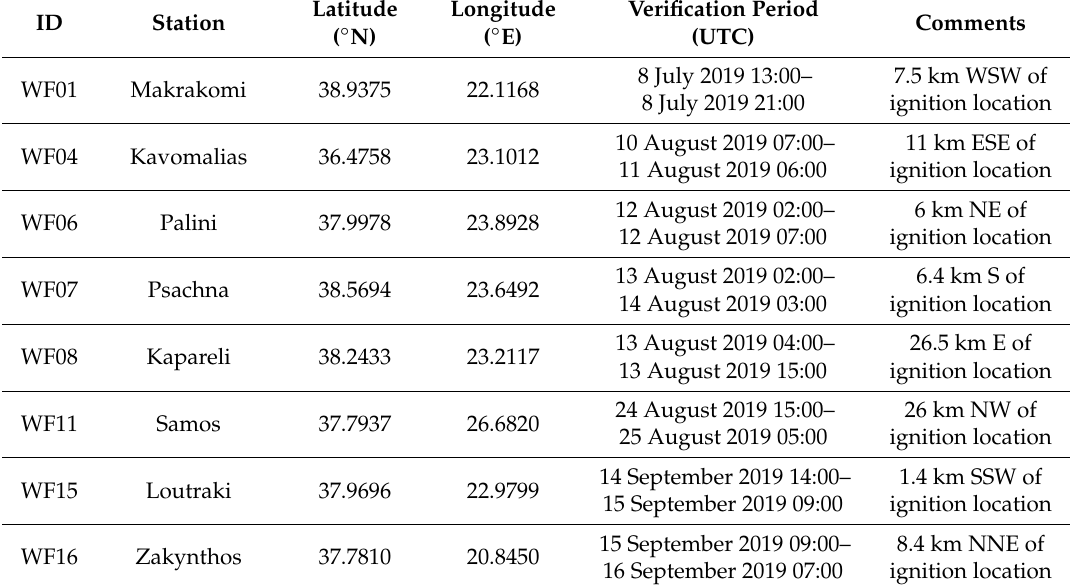
Table 2. Summary of the automatic weather stations (AWSs) used for the evaluation of IRIS’s wind